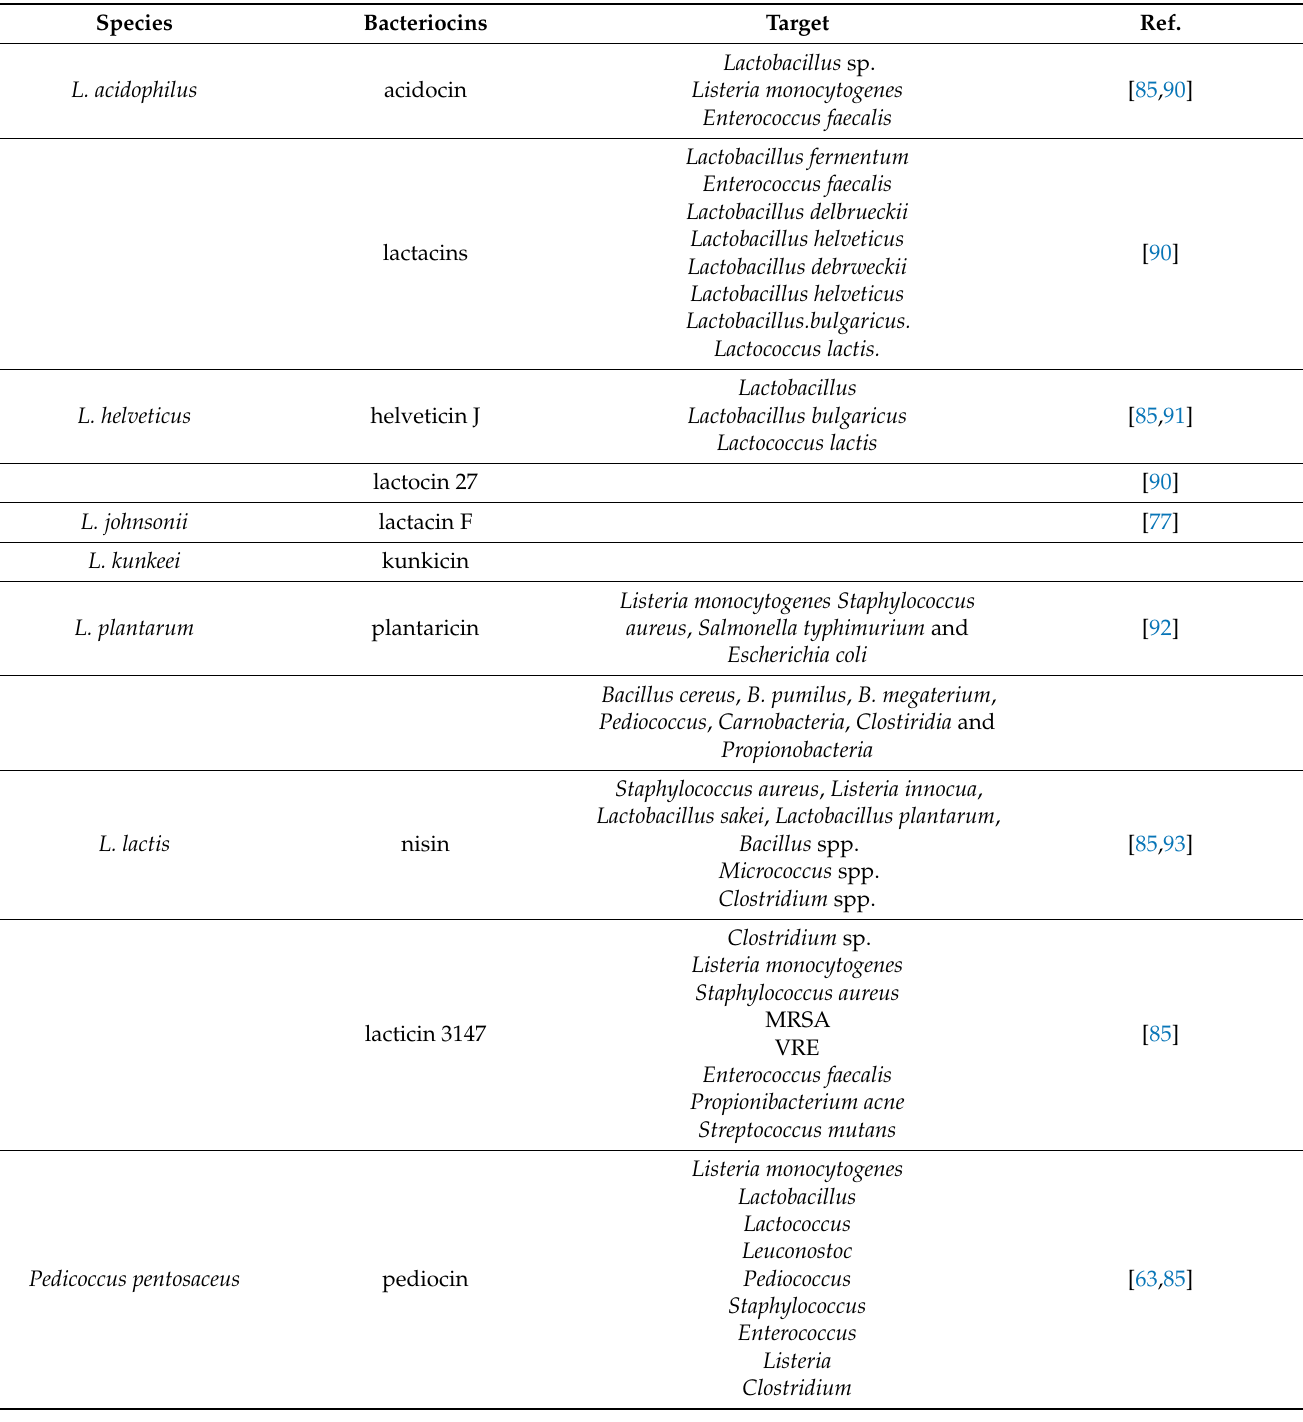
Table 5. Putative bacteriocins produced by lactobacilli detected in honey and honey